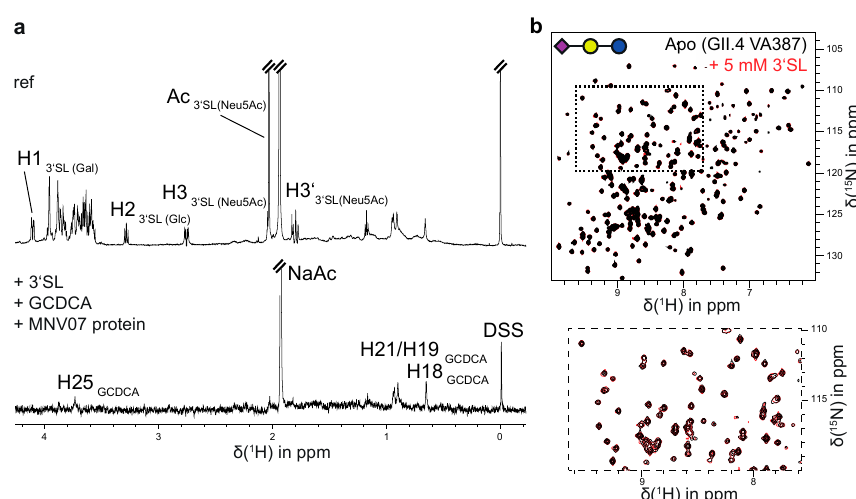
Figure 4. MNV and GII.4 P-domains do not bind to sialic acid containing glycans. ( a ) STD NMR spectra of MNV07 P-domains in the presence of the ligand GCDCA and 3 ′ -sialyllactose (3 ′ SL). There is no saturation transfer to protons of 3 ′ SL. Only GCDCA signals show STD effects. The sample contained 80 μ M protein in 20 mM sodium acetate buffer (pH 5.3), 250 μ M GCDCA, and 2 mM 3 ′ SL. Spectra were acquired at 298 K at 600 MHz. ( b ) 1 H, 15 N TROSY HSQC spectra of 170 μ M [ U - 2 H, 15 N]-labeled HuNoV GII.4 VA387 P-dimers with and without 3 ′ SL showing no binding of 3 ′ SL. A representative section of the spectra highlights the absence of CSPs upon 3 ′ SL addition. The sample was prepared in 75 mM sodium phosphate buffer, 100 mM NaCl (pH 7.3). Table 3. Sialylated ganglioside glycans tested negative for binding to human NoV P-domains. NMR samples were prepared in the following buffers. A: 20 mM sodium phosphate (pH 7.4), B: 75 mM sodium phosphate, 100mM NaCl (pH 7.3), C: 100 mM sodium acetate (pH 4.6), D: 200 mM ammonium